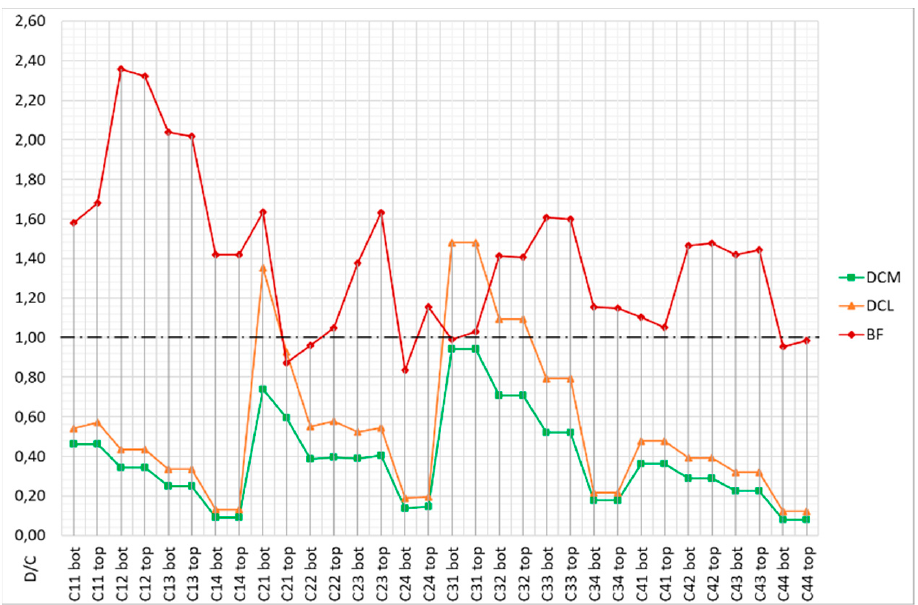
Figure 5. NC flexural 𝐷 𝐶⁄ ratios on columns ( q- factor approach results).